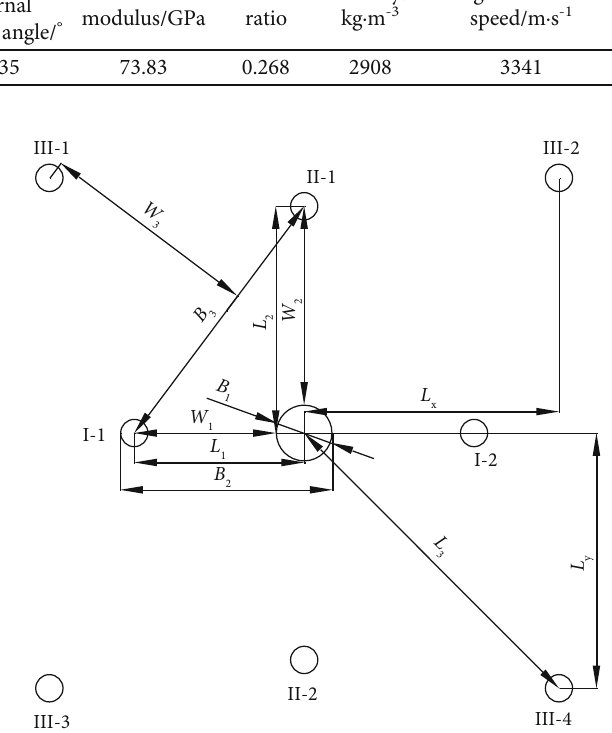
Table 1: Statistics of physical and mechanical parameters of marble in Dahongshan Copper Mine. Rock